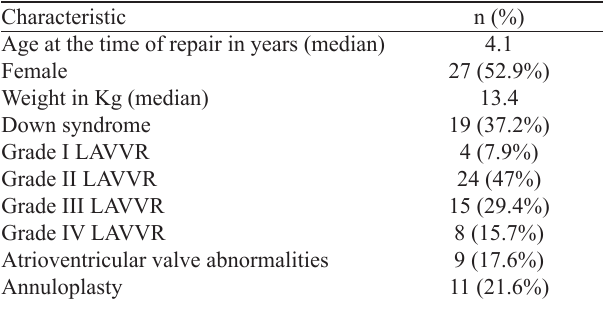
Table 1. Pre- and intraoperative characteristics of the patients enrolled in the study.